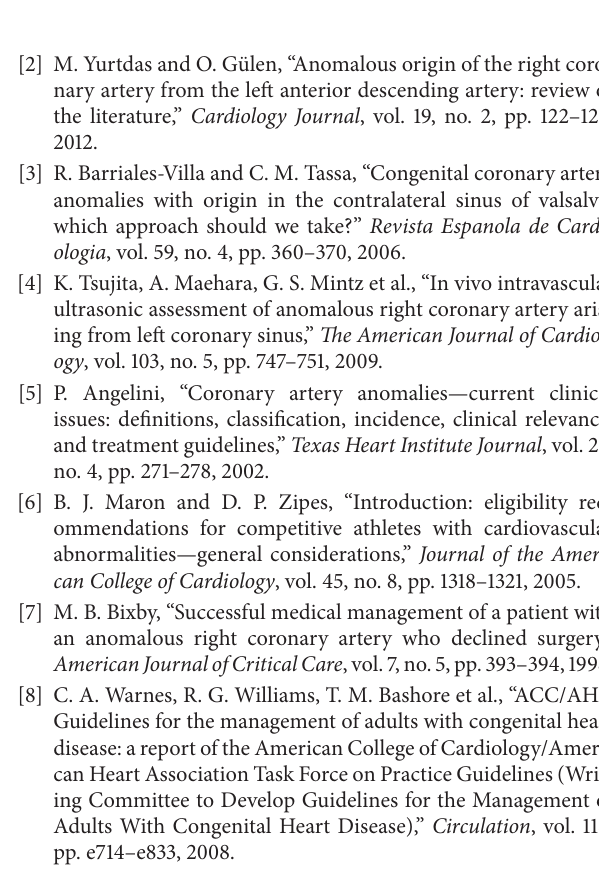
Figure 4: (a)–(c) Reconstruction 3D cardiac MSCT shows RCA originated from left sinus of Valsalva adjacent to LCA ostium with interarterial course between ascending aorta and pulmonary artery through right atrioventricular